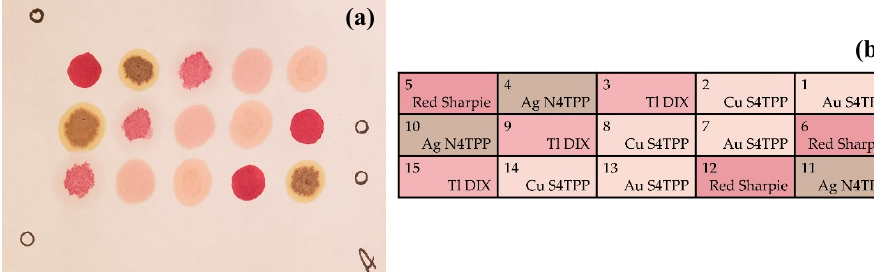
Figure 5. The coupon layout used for the trials described here. This coupon includes three copies of each of four indicators as well as three negative control spots created using red Sharpie ®® ink. Index markings at the edges of the coupon guide the orientation on the sensor device. ( a ) Photograph of a coupon. ( b ) Identification of the indicator locations used in the coupons.